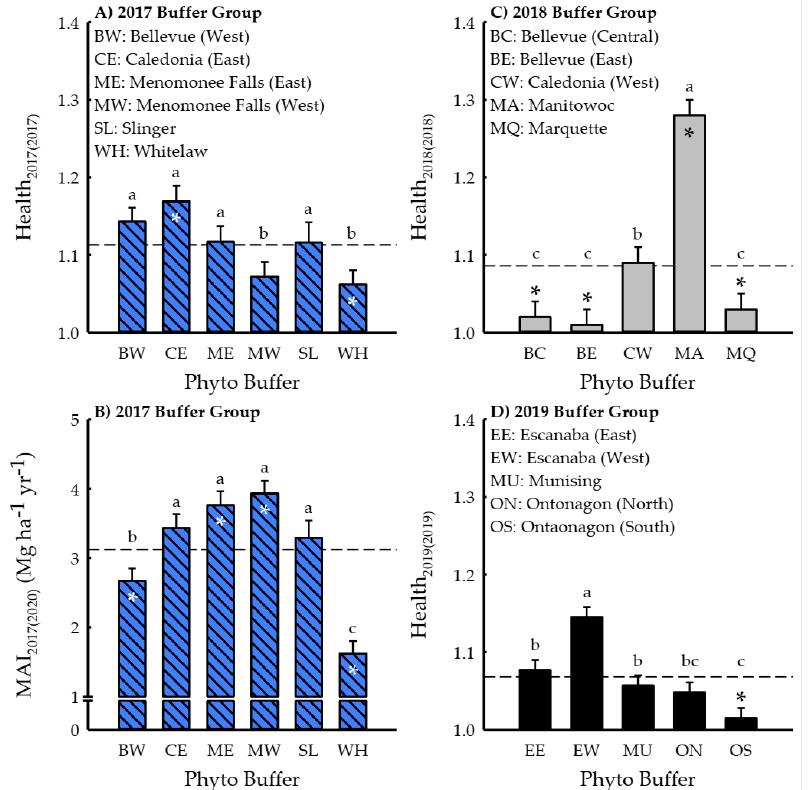
Figure 2. First-year tree health ( A ) and fourth-year mean annual increment (MAI) ( B ) of six phytore- mediation buffers (i.e., phyto buffers) established in 2017 (i.e., the 2017 Buffer Group), in addition to the first-year tree health of five phyto buffers established in the 2018 Buffer Group ( C ) and 2019 Buffer Group ( D ) of a regional phytotechnologies network in the Lake Superior watershed of the Upper Peninsula of Michigan, USA and the Lake Michigan watershed of eastern Wisconsin, USA. Error bars represent one standard error of the mean. The dashed line represents the overall mean, and asterisks indicate means different than the overall mean at p < 0.05. Bars with different letters are different at p < 0.05. See Section 2 for complete tree health definitions (1 = optimal health, 2 = good health, 3 = moderate health, 4 = poor health, and 5 =